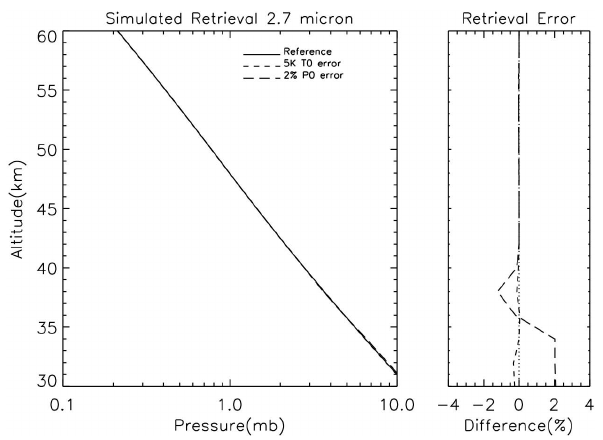
Fig. 10. Same as Fig. 9 but for pressure.